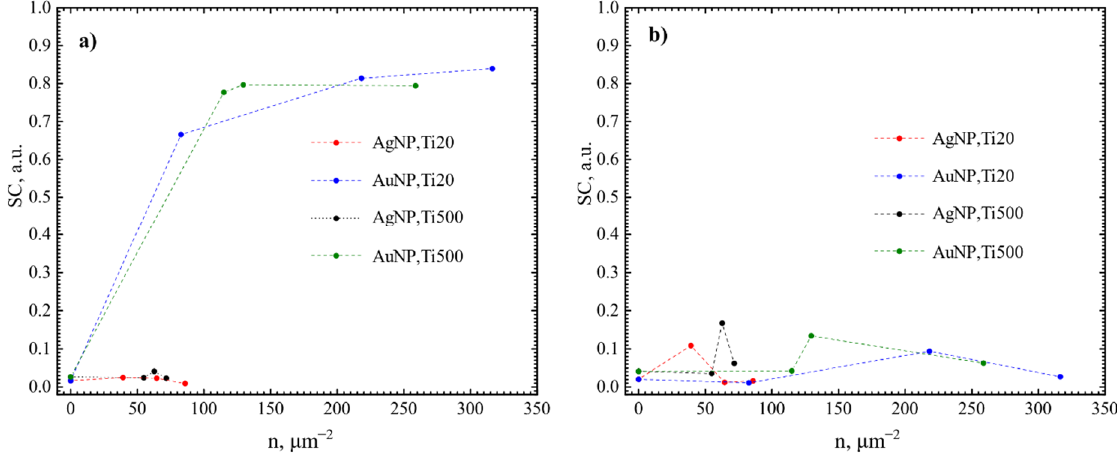
Figure 11. Surface coverage of NP/TiO 2 system by bacteria: ( a ) N. sicca , ( b ) V.